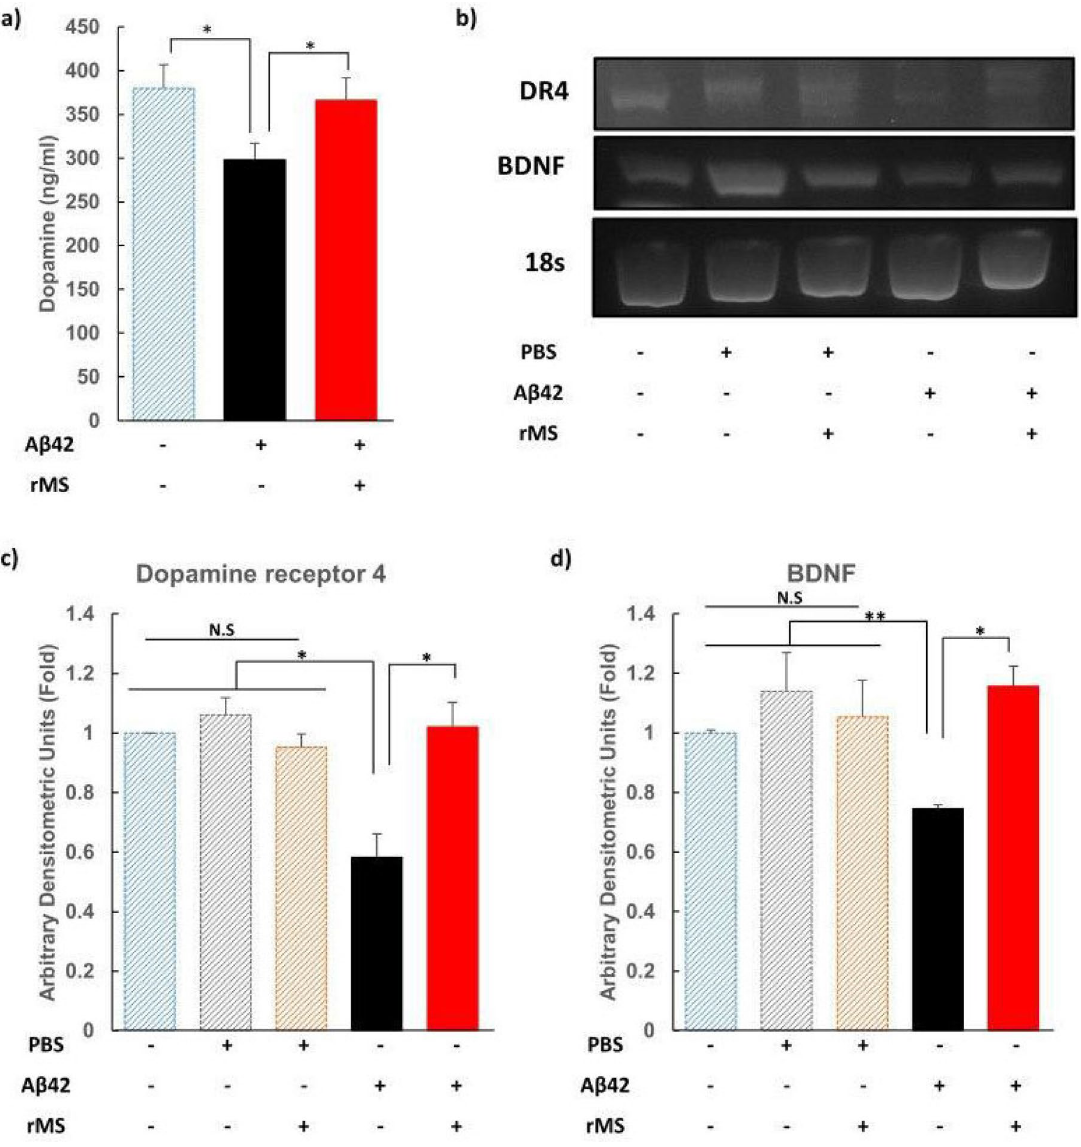
Figure 5. rMS increased expression of DR4 in vitro HT-22. The Aβ42 was added to the hippocampal cell line of mouse (20 μM Aβ42 was treated at 24 h in the serum free condition in specifically HT-22 cells). ( a ) Dopamine levels were measured by ELISA. ( b ) Gene expression of DR4 and BDNF was measured by RT-PCR. Densitometry analysis of RT-PCR ( c ) DR4, ( d ) BDNF. Data are shown as the DR4 or BDNF/18 s ratio. The mRNA level of 18 s was analysed as an internal control. Each group n = 4, mean ± SEM. * Ps < 0.05, ** Ps < 0.01. + treatment, − none treatment of PBS/Aβ42 oligomer/rMS, rMS repetitive magnetic stimulation with 20 Hz frequency, DR4 Dopamine receptor 4, Aβ42 amyloid beta 42 oligomer, ELISA Enzyme-Linked Immunosorbent Assay, BDNF brain-derived neurotrophic factor, RT-PCR reverse transcription polymerase chain reaction, PBS Phosphate-buffered saline, N.S. not